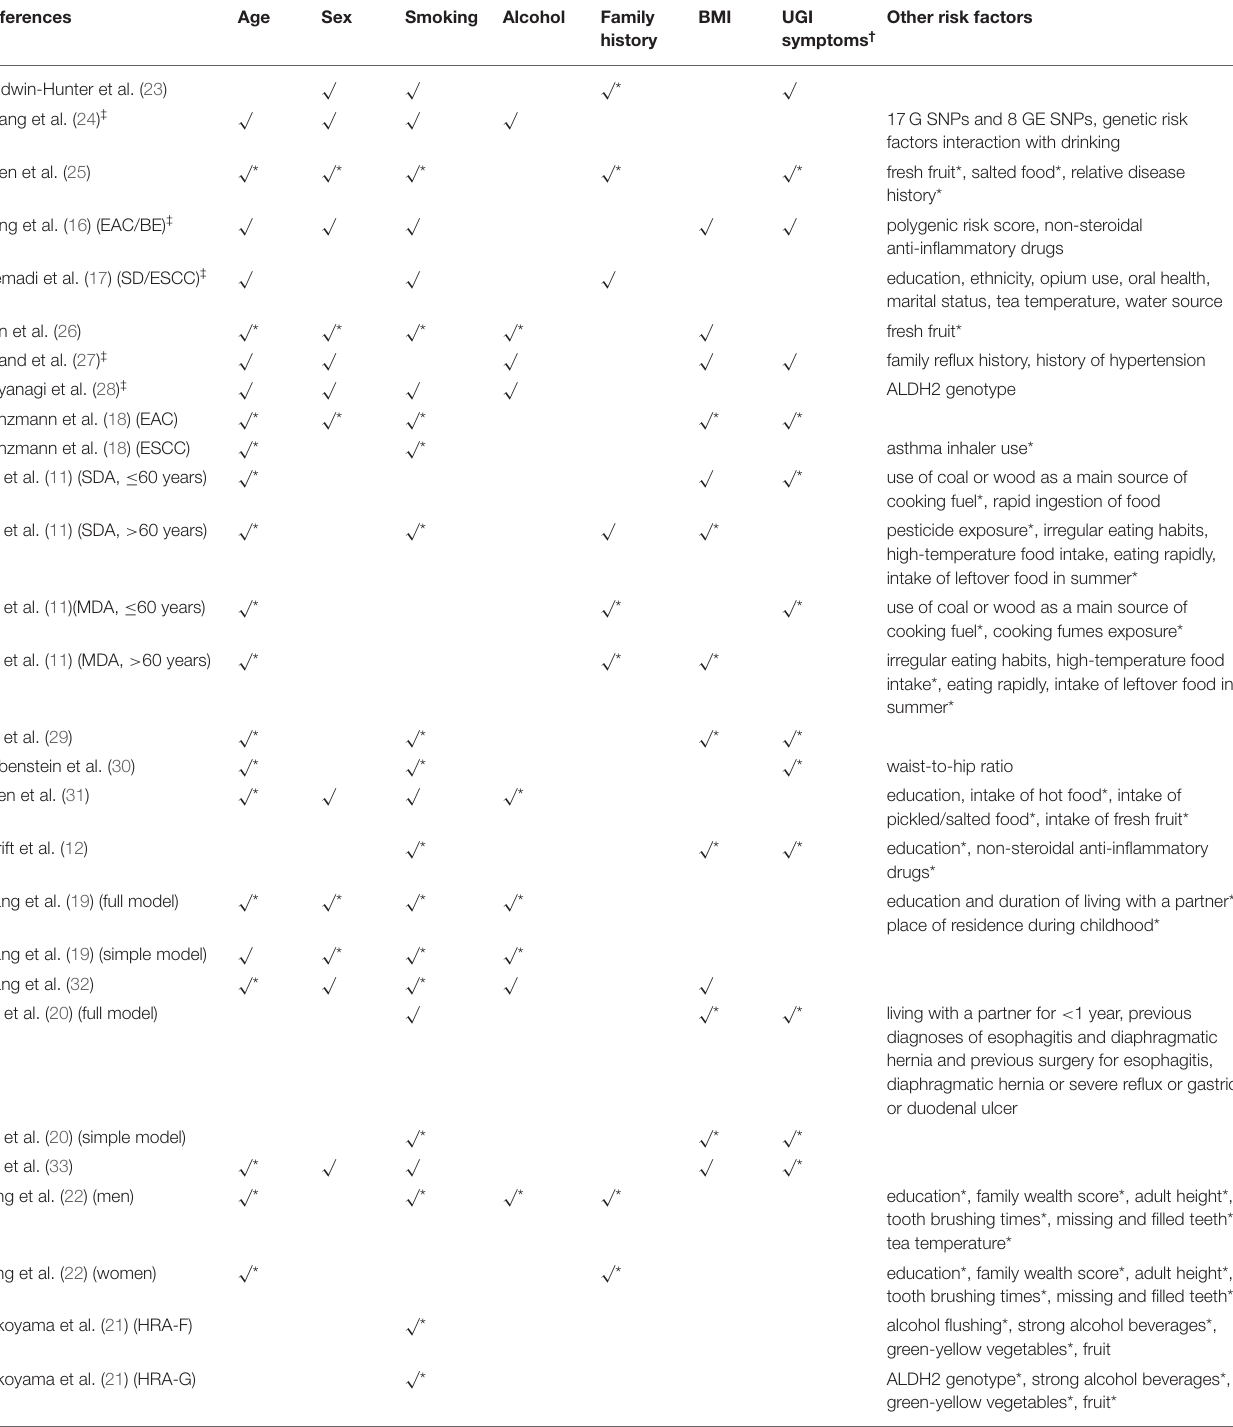
TABLE 2 | Overview of risk factors included in the risk prediction